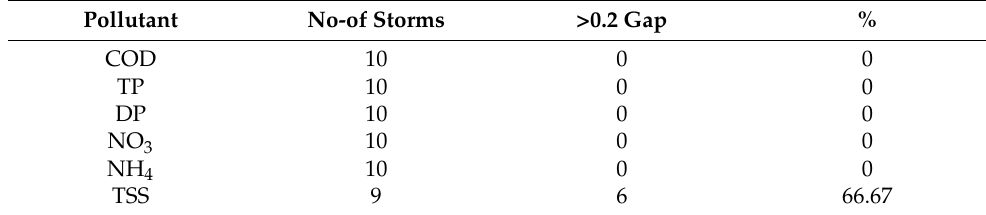
Table 7. Method 2 results summary.